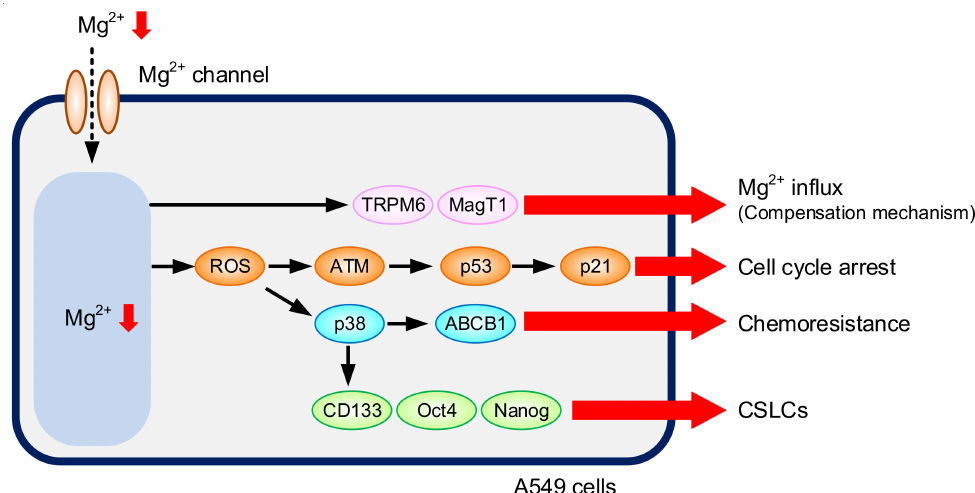
Figure 9. A putative model of LM-induced responses. [Mg 2+ ] i is reduced in the cells continuously cultured with LM. LM induces G1-S cell cycle arrest mediated through the elevation of p-ATM, p-p53, and p21. The mRNA levels of TRPM6 and MagT1 are increased by LM. LM increases the mRNA and protein levels of ABCB1 mediated by the activation of p38, leading to the acquisition of chemoresistance. LM increases CD133-positive cells, indicating the elevation of proportion of